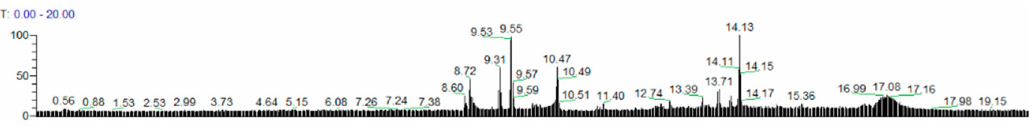
Figure 2. Ion flow chromatogram of